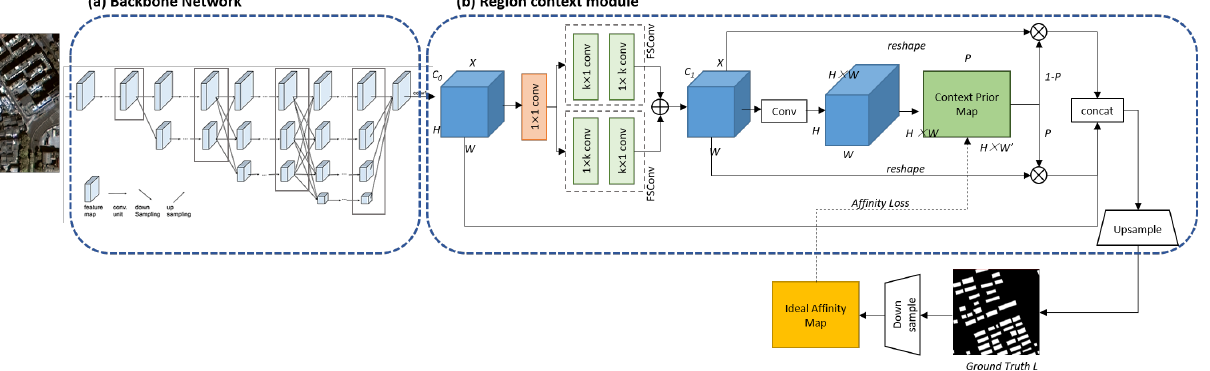
Figure 4. Overview of the proposed building and road extraction network. It is composed of ( a ) HRNet backbone network, and ( b ) a region context module (RCM). The RCM uses aggregation module output to learn a region affinity map that gathers contextual information surrounding each pixel. The RCM output feature map is then upsampled for prediction. (Notation: Conv standard convolution, FSConv fully separable